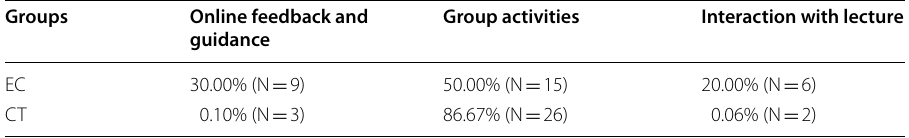
Table 6 Learning activities impacting project design and development Groups